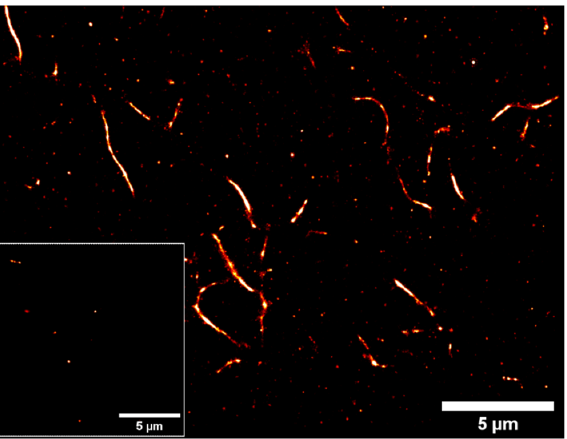
Figure 9. STORM image of AF647-functionalized SWNTs. Inset: Control experiment of nanotubes with AF647 (not functionalized). Imaging conditions: 20K frames recorded. Activation laser wave- length: 405 nm. Excitation laser wavelength: 642 nm.